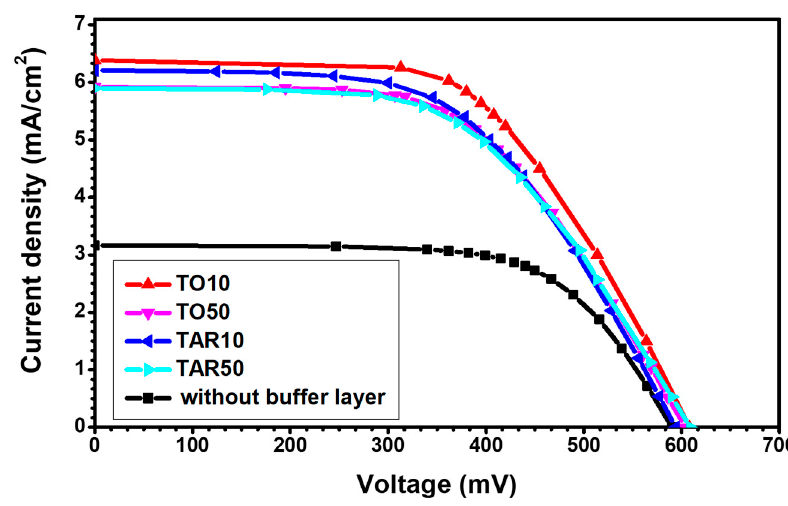
Figure 8. Current-voltage ( I-V ) curves for typical DSSCs fabricated using photo-electrodes with various buffer layers: TO10 (dashed line), TO50 (dotted line), TAR10 (dashed dotted line) or TAR50 (dashed dotted dashed line). The measurements were performed under standard air mass 1.5 global (AM 1.5G) illumination conditions.